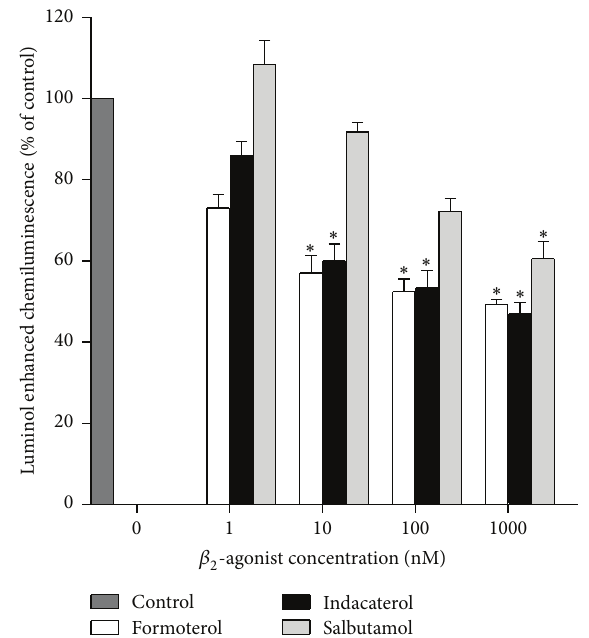
Figure 1: Effects of formoterol, indacaterol, and salbutamol (1 – 1000 nM) on the luminol-enhanced chemiluminescence responses of neutrophils activated by N-formyl-L-methionyl-L-leucyl-L- phenylalanine (fMLP, 1 𝜇 M). The results are expressed as the mean percentage of control ± SEM ( 𝑛 = 5 ) with duplicate values for each drug concentration and control system in each experiment. The absolute values for unstimulated neutrophils and for cells activated with fMLP in the absence of the drugs were 2136 ± 219 and 20394 ± 1447 relative light units respectively; ∗ 𝑃 < 0.04 – 0.004 for comparison with the fMLP-activated, drug-free control system.